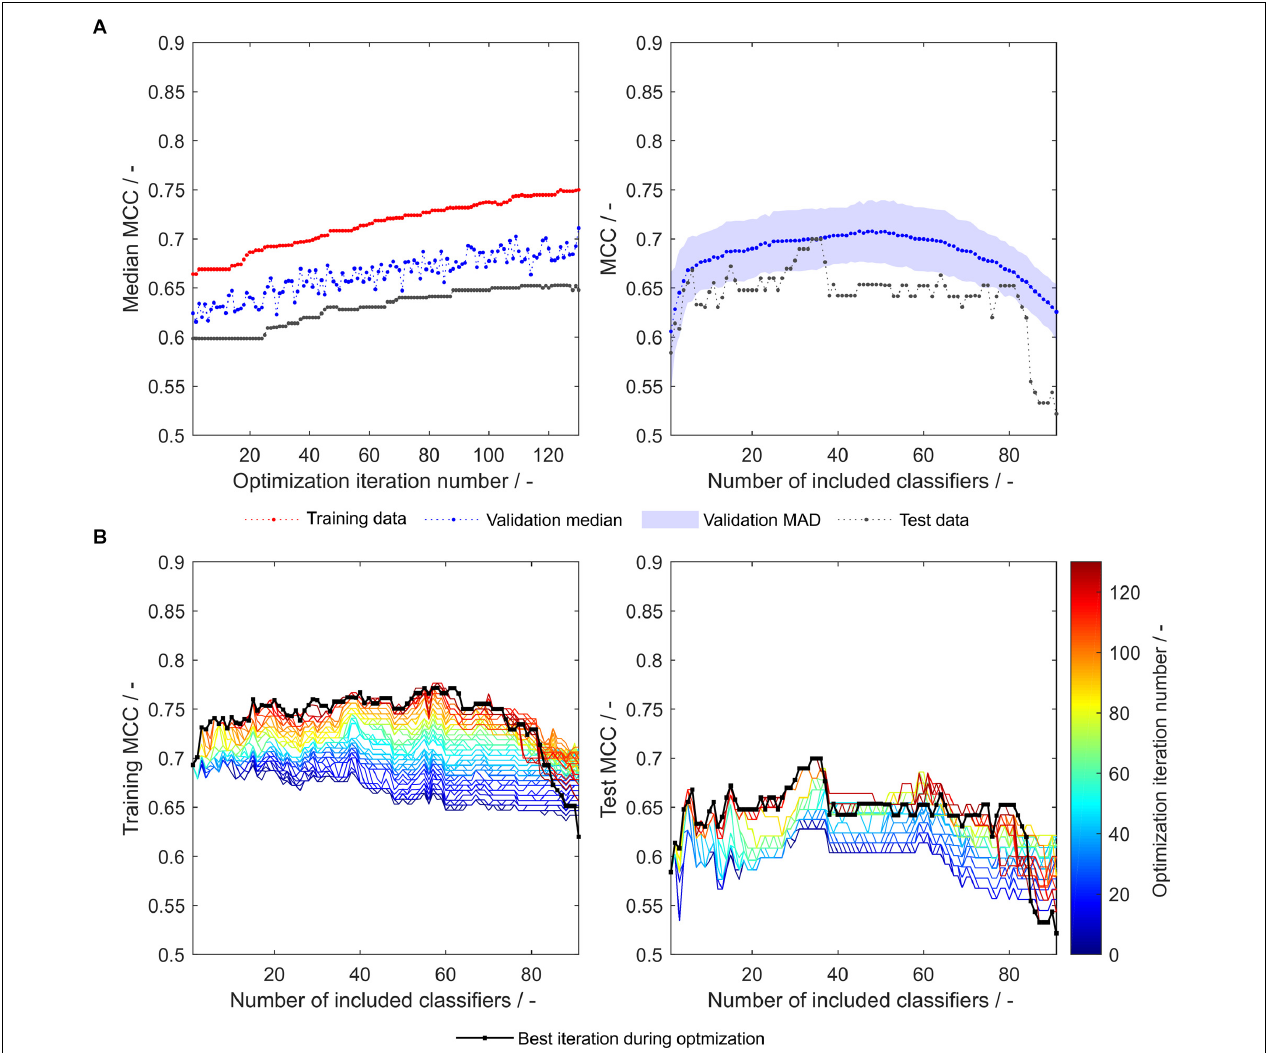
FIGURE 3 | Matthew’s correlation coefficient (MCC) during insertion strategy-based model optimization. Scales used were the unmodified 91 literature scales. Median MCC are shown for training, validation, and test data over optimization iterations ( A , left). Validation and test MCC are shown over number of included classifiers in the soft ensemble vote classifier (sEVC; A , right) for the best model in the optimization procedure. The median absolute deviation (MAD) of the validation MCC above and below the median validation MCC is visualized with a shaded area. Training and test MCC over number of included classifiers are shown for the optimization iterations until the best iteration, where median validation MCC was highest (B) . Optimization iterations are illustrated by a colormap, where dark blue represents the first iteration and dark red the best iteration, highlighted by the black